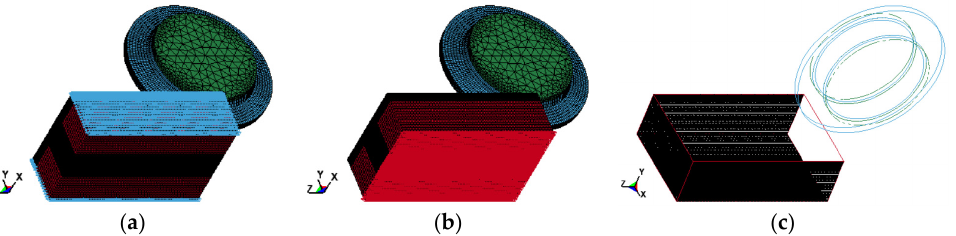
Figure 9. Boundary conditions of the rock mass. ( a ) Constraints in the two side; ( b ) Constraints in the bottom; ( c ) Non-reflective boundaries.